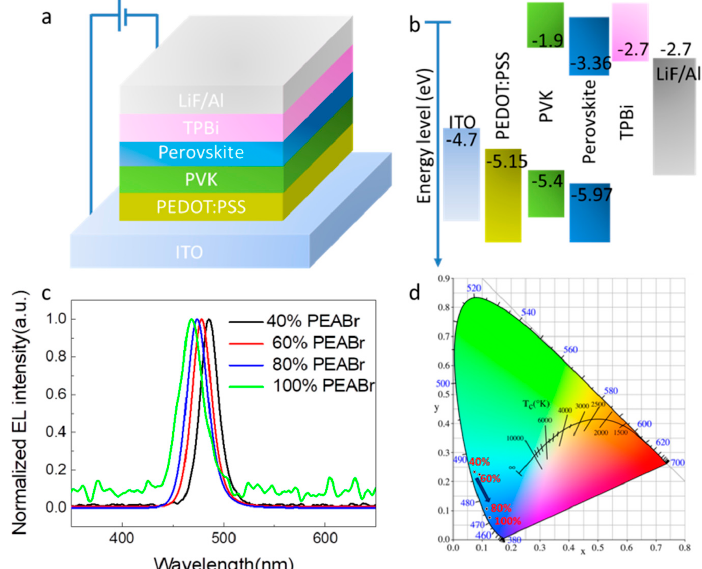
Figure 4. ( a ) PeLED architecture. ( b ) Energy levels for different layers of the device. ( c ) EL spectra of PeLEDs with different ratios of PEABr. ( d ) CIE values of the EL spectra of PeLEDs.